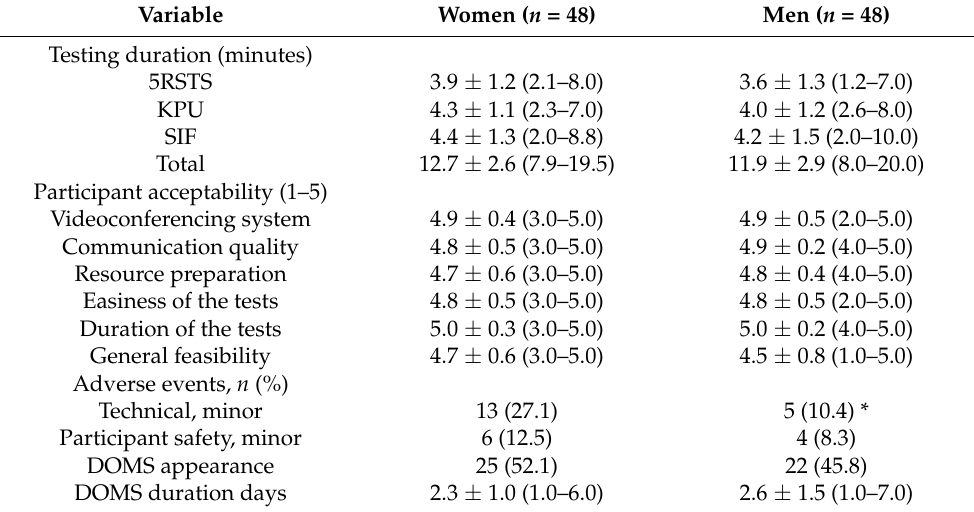
Table 4. Summary of feasibility